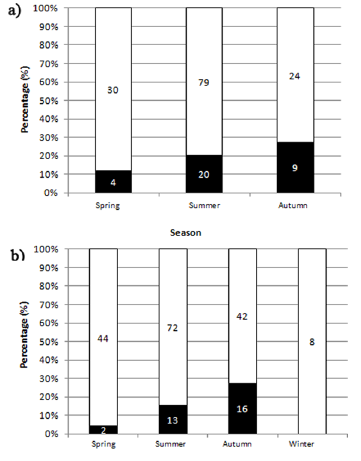
Figure 3. Seasonal pattern of blood parasite in the studied area. Numbers in bars indicate sample size. (A) Percentage of infected (black) and uninfected (white) blood-fed mosquitoes. Note: No blood-fed mosquitoes were captured in winter. (B) Percentage of pools containing infected (black) and uninfected (white) unfed mosquitoes. Note: for the case of mosquitoes in pools, figure show proportions of infected pools but not parasite prevalence. The seasonal infection prevalence (95% coeficient intervals) for mosquitoes in pools were: Spring = 0.56% (0.09–1.74), Summer = 0.99% (0.55–1.64), Au- tumn=2.54% (1.47–4.06).